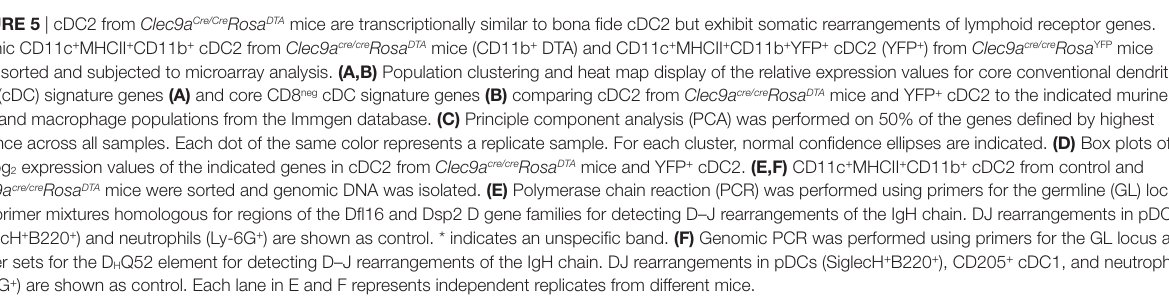
FigUre 5 | cDC2 from Clec9a Cre/Cre Rosa DTA mice are transcriptionally similar to bona fide cDC2 but exhibit somatic rearrangements of lymphoid receptor genes. Splenic CD11c + MHCII + CD11b + cDC2 from Clec9a cre/cre Rosa DTA mice (CD11b + DTA) and CD11c + MHCII + CD11b + YFP + cDC2 (YFP + ) from Clec9a cre/cre Rosa YFP mice were sorted and subjected to microarray analysis. (a,B) Population clustering and heat map display of the relative expression values for core conventional dendritic cells (cDC) signature genes (a) and core CD8 neg cDC signature genes (B) comparing cDC2 from Clec9a cre/cre Rosa DTA mice and YFP + cDC2 to the indicated murine cDC and macrophage populations from the Immgen database. (c) Principle component analysis (PCA) was performed on 50% of the genes defined by highest variance across all samples. Each dot of the same color represents a replicate sample. For each cluster, normal confidence ellipses are indicated. (D) Box plots of the log 2 expression values of the indicated genes in cDC2 from Clec9a cre/cre Rosa DTA mice and YFP + cDC2. (e,F) CD11c + MHCII + CD11b + cDC2 from control and Clec9a cre/cre Rosa DTA mice were sorted and genomic DNA was isolated. (e) Polymerase chain reaction (PCR) was performed using primers for the germline (GL) locus and primer mixtures homologous for regions of the Dfl16 and Dsp2 D gene families for detecting D–J rearrangements of the IgH chain. DJ rearrangements in pDCs (SiglecH + B220 + ) and neutrophils (Ly-6G + ) are shown as control. * indicates an unspecific band. (F) Genomic PCR was performed using primers for the GL locus and primer sets for the D H Q52 element for detecting D–J rearrangements of the IgH chain. DJ rearrangements in pDCs (SiglecH + B220 + ), CD205 + cDC1, and neutrophils (Ly-6G + ) are shown as control. Each lane in E and F represents independent replicates from different